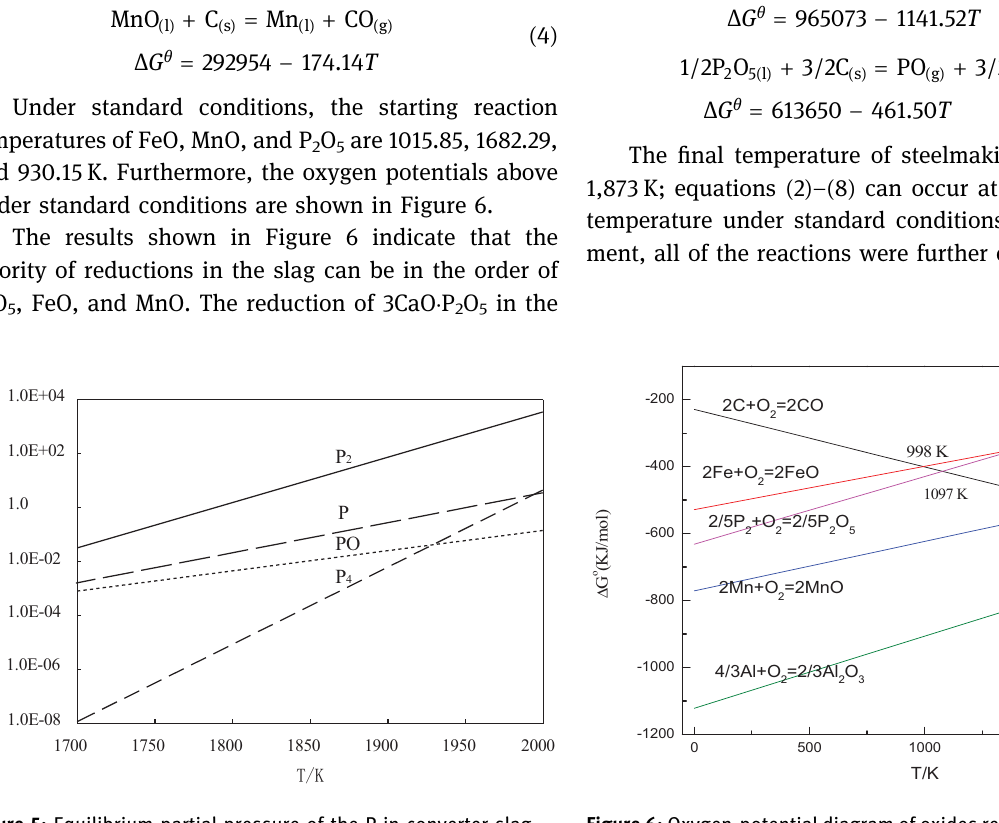
Figure 5: Equilibrium partial pressure of the P in converter slag. Figure 6: Oxygen - potential diagram of oxides reduced by element